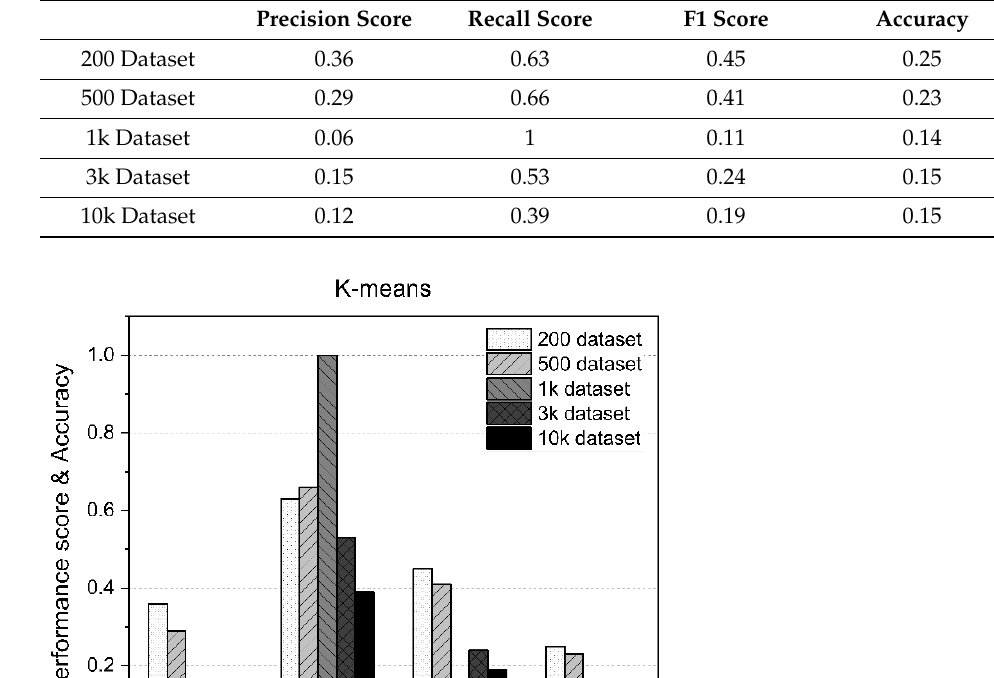
Table 7. Results of the KNN.